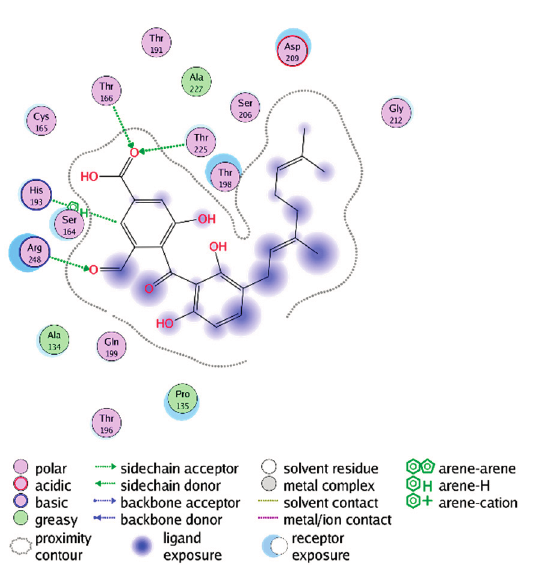
Figure 4. Interactions between the lowest-energy docking pose of Compound 2 (NP-013296) and the G-3-P site of Tb GAPDH (PDB-ID 2X0N).